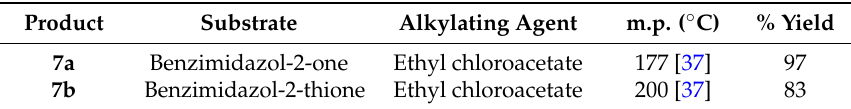
Table 8. Milling of 2.5 g of benzimidazol-2-one or benzimidazol-2-thione, 2 g of sodium hydride and 2.2 equivalent of alkylating agent with 56.6 g of balls for 20 min at 20 Hz.